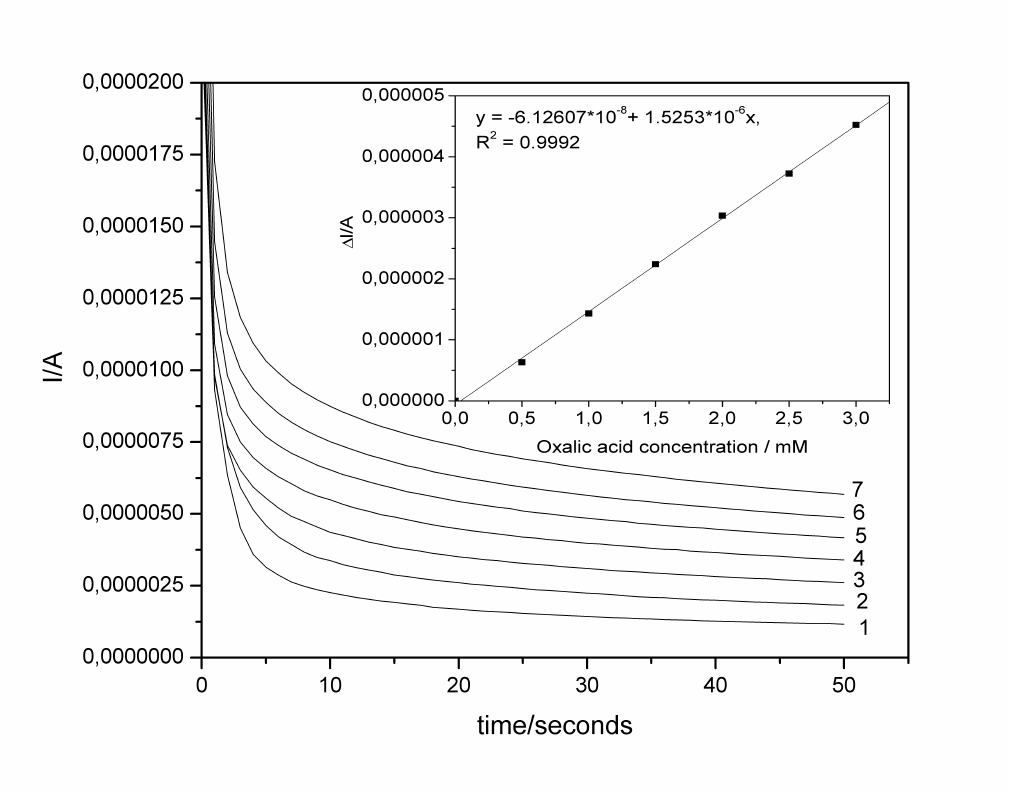
Figure 6. Chronoamperograms obtained at EG-PS in the absence (1) and the presence of (2) 0.5 mM, (3) 1 mM, (4) 1.5 mM, (5) 2 mM, (6) 2.5 mM, (7) 3 mM; 0.1 M Na electrode potential 1.1 V vs. SCE; Inset: the calibration plots of current, read at 50 seconds, vs. oxalic